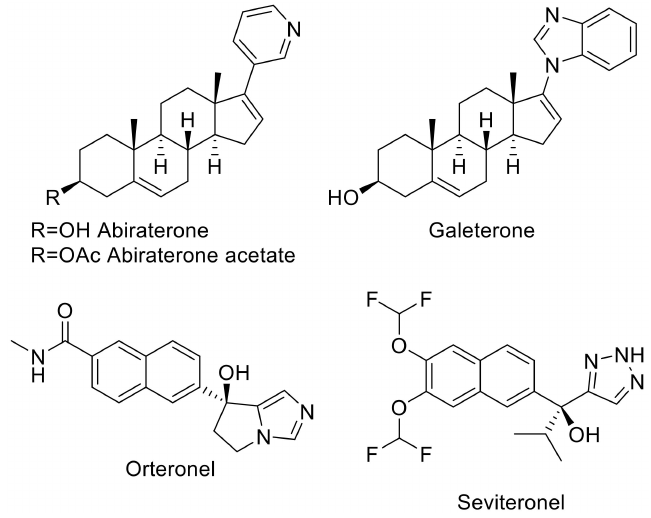
Figure 1. Structures of the cytochrome P450 17A1